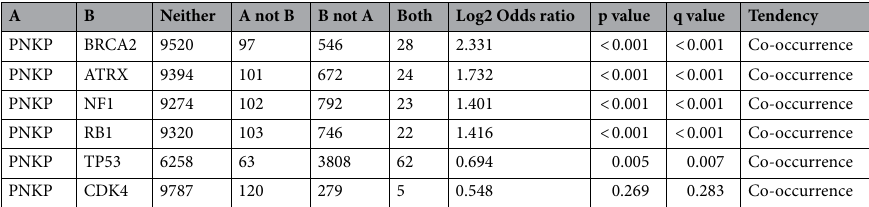
Core at the University of Alberta. Besides the site directed mutagenesis sites (C302T for P101L mutation; C968T